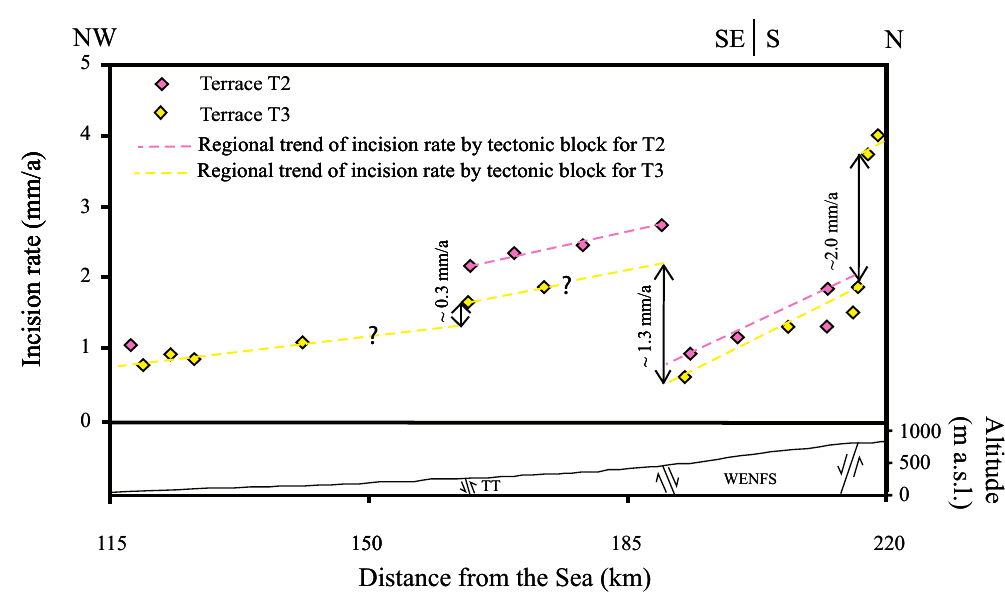
Figure 11. Evolution of the incision rate along the river profile of the Osum. Bold lines represent normal faults belonging to West Ersekë Normal Fault System (WENFS) and Tomorrica Thrust